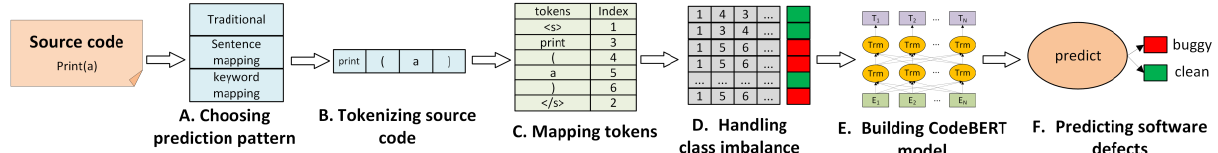
Figure 4. The overall workflow of our approach for software defect